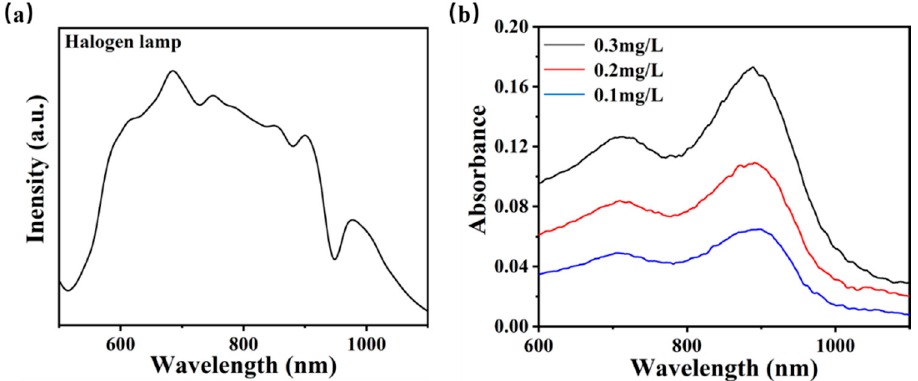
Figure 2. Characterization of light source and pre-validation of chromogenic reaction; ( a ) spectrum of the halogen lamp as the broadband light source; ( b ) the absorbance of the pre-validation solution converted by orthophosphate samples with different concentrations.